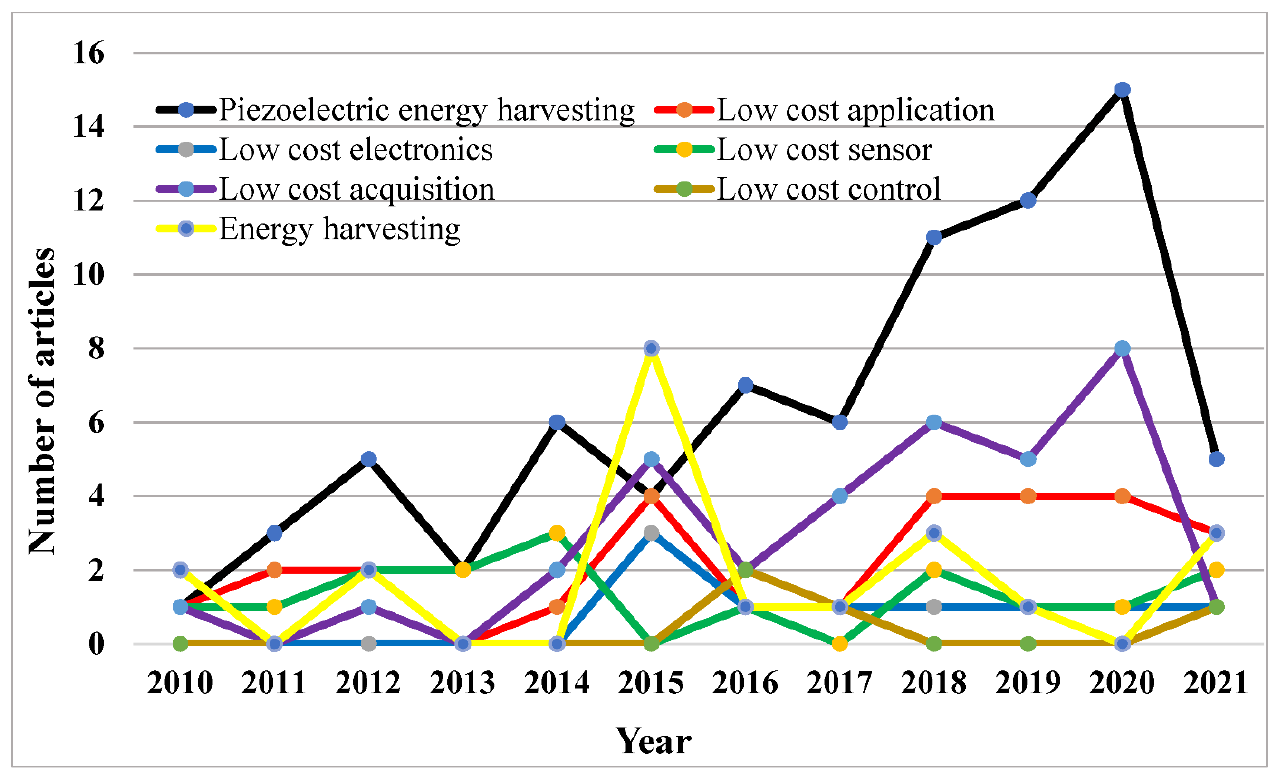
Figure 2. The frequency of manuscripts per year.